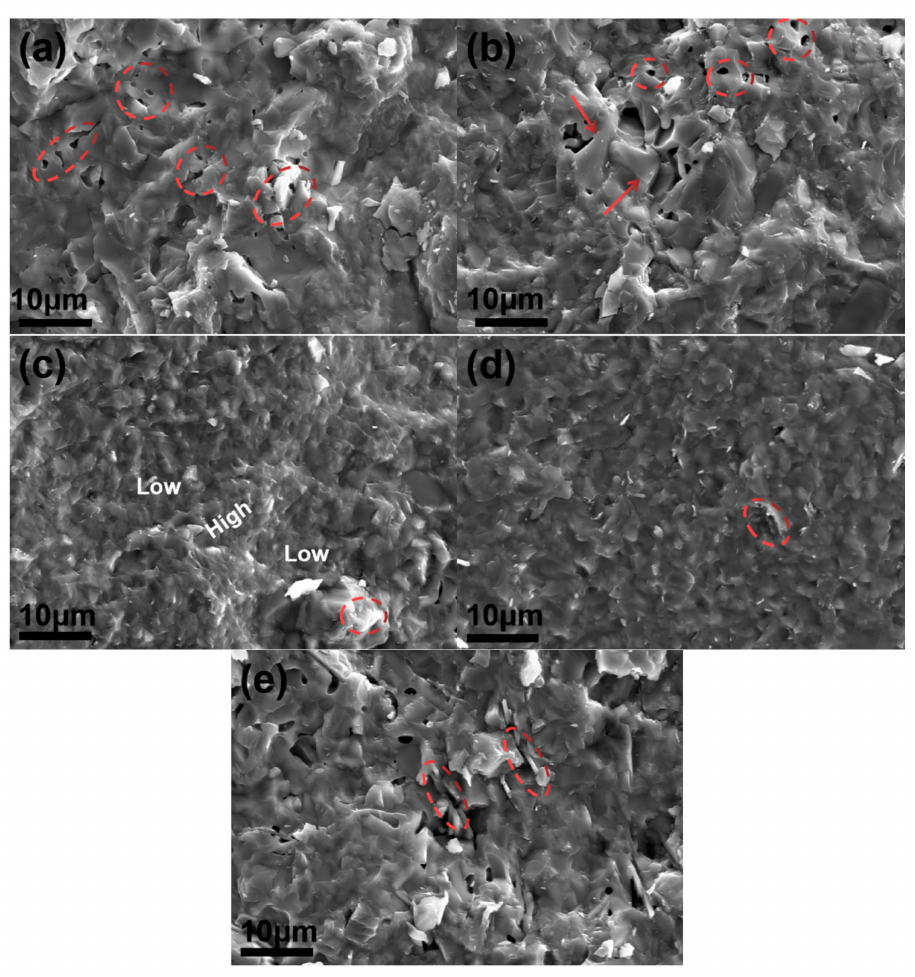
Figure 6. SEM images of fracture surface, ( a ) S1; ( b ) S2; ( c ) S3; ( d ) S4; ( e )